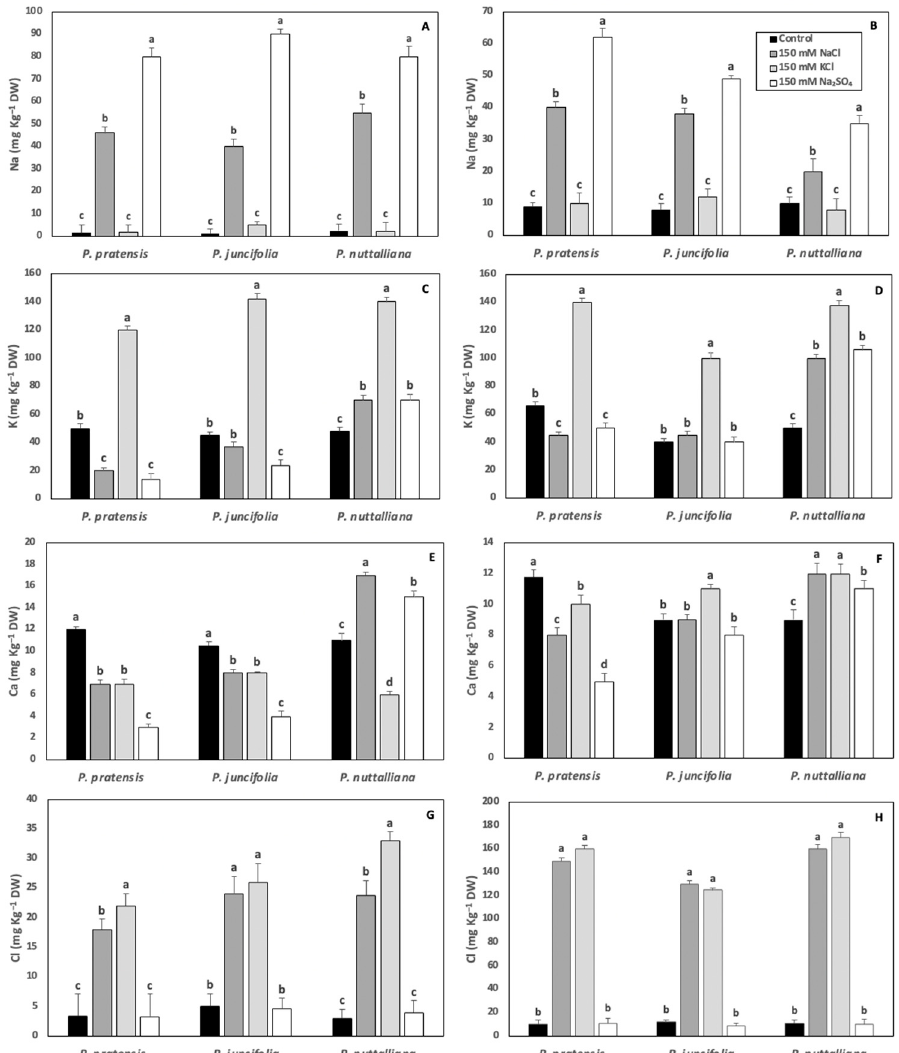
Figure 6. Concentrations of Na, K, Ca, and Cl in roots ( A , C , E , G ) and shoots ( B , D , F , H ) of Poa pratensis , Poa juncifolia , and Puccinellia nuttalliana after 10 days of treatments with 150 mM NaCl, 150 KCl, 150 mM Na 2 SO 4 and in untreated control plants. Different letters above the bars indicate significant differences ( p ≤ 0.05) between treatments within each plant species as determined by the Tukey’s test. Means ( n = 6) and SE are shown.